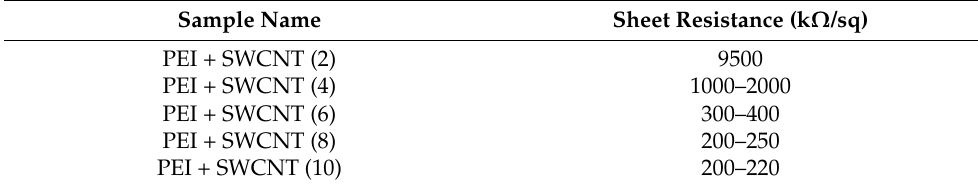
Table 2. Sheet resistance of PEI+SWCNT with up to 10